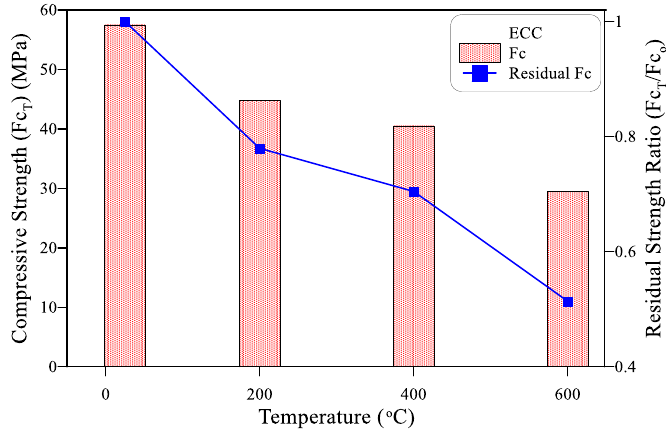
Figure 3. Residual compressive strength of ECC at different temperatures.